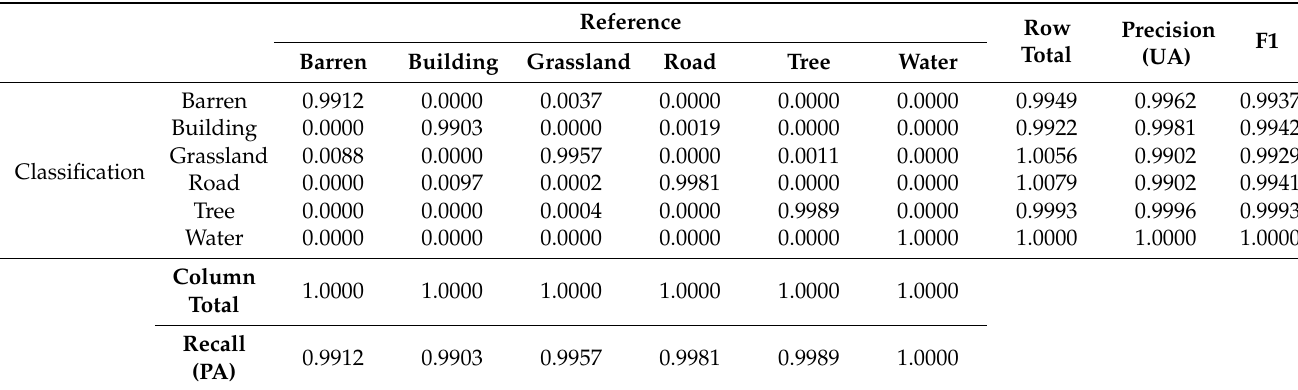
Table 5. Scene labelling accuracy assessment for DeepSat SAT-6 dataset, with accuracy values in each column summing to 1.0, an approach often used in DL studies. OA =